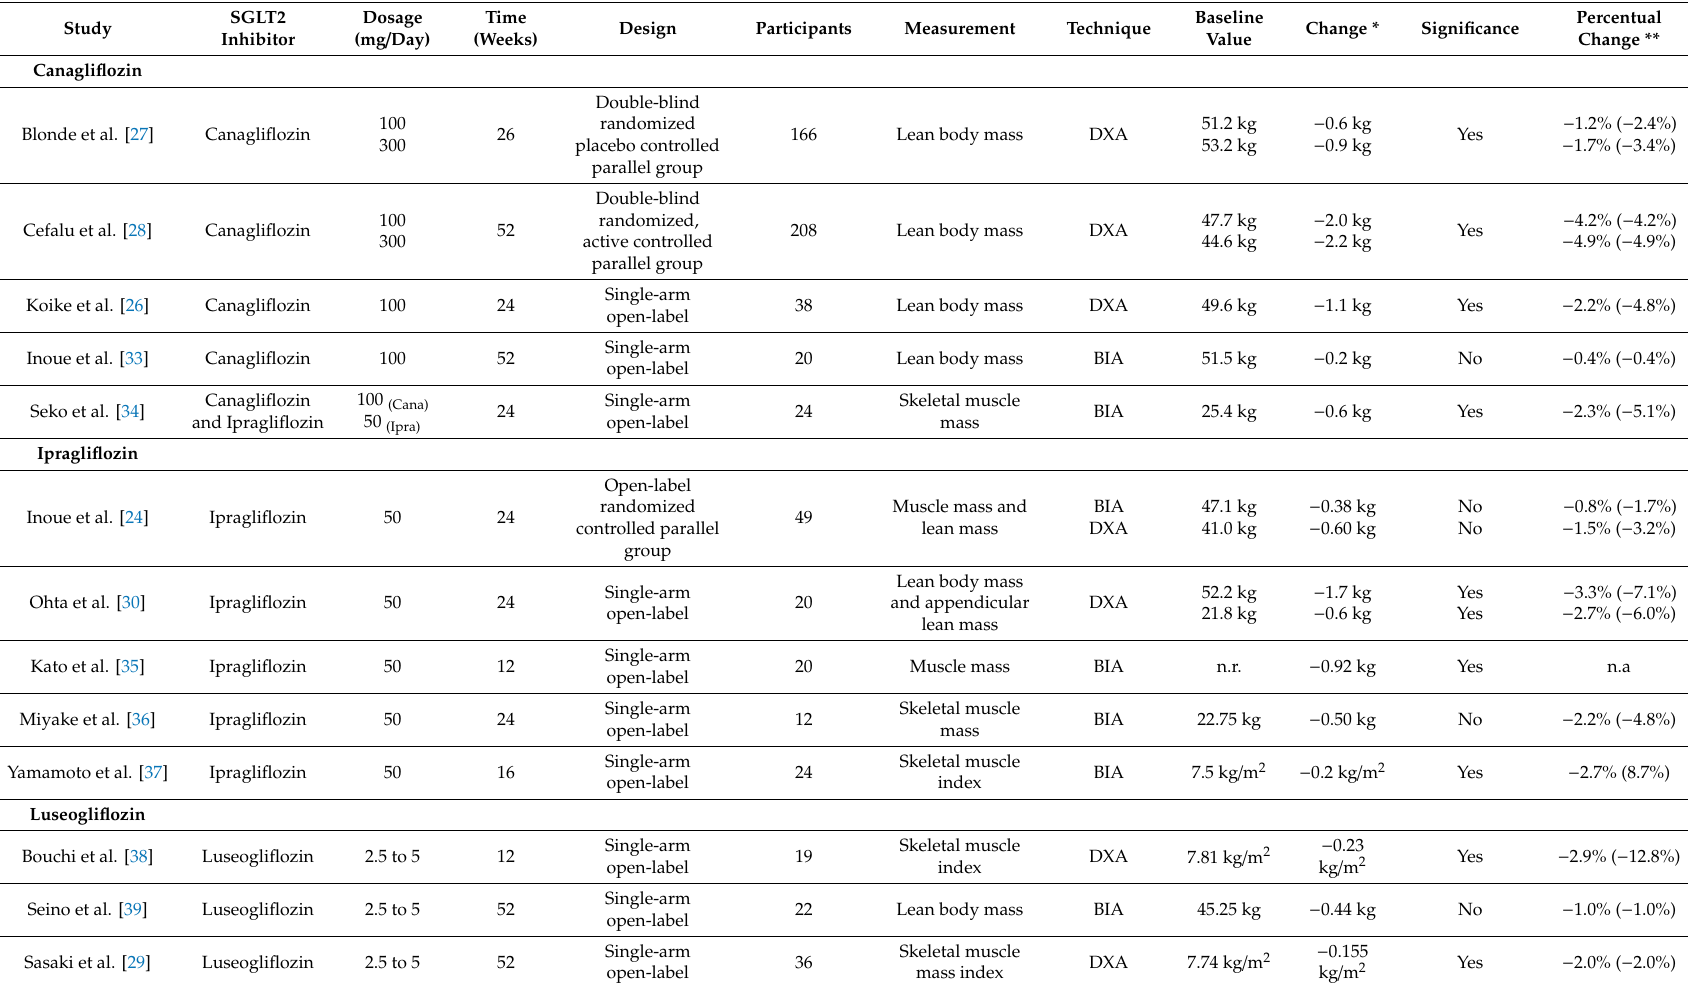
Table 1. Overview of the e ff ects of SGLT2 inhibitors on lean body mass and muscle